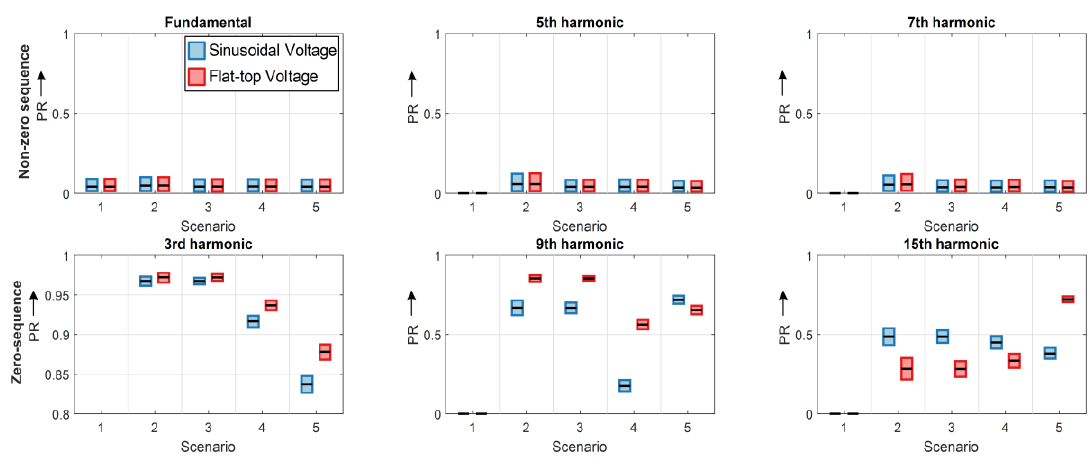
Figure 10. Comparison of selected prevailing ratios (PRs) at analysis point 1.